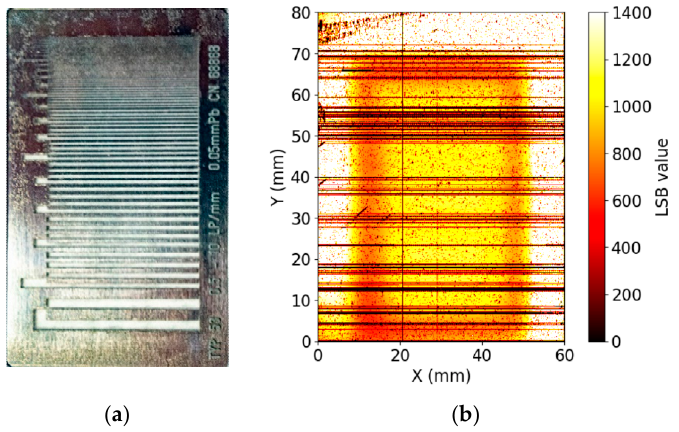
Figure 9. ( a ) Line pair mask type 53 made of 0.05 mm thick lead used as an imaging target. ( b ) Heat map of the MTF mask after irradiation with 30 kV X-rays.